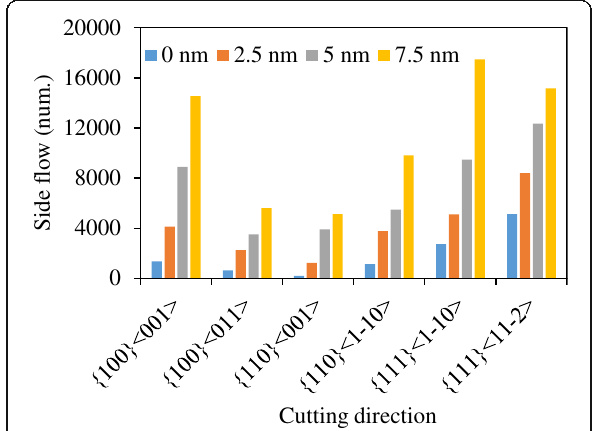
Fig. 12 Number of atoms flow to the side of tool edge with different tool edge radius r β